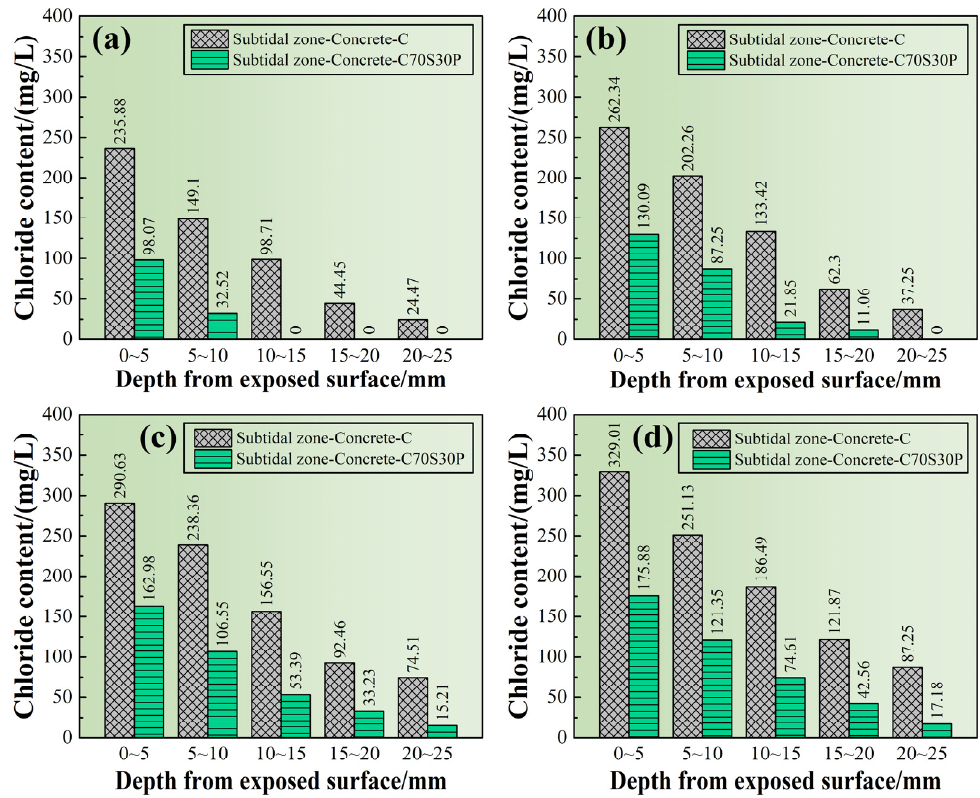
Figure 20. The chloride ions’ profile of CBRM-Concrete serving in the subtidal zone simulated environment. ( a ) 18 + 30 days, ( b ) 18 + 60 days, ( c ) 18 + 90 days, and ( d ) 18 + 180